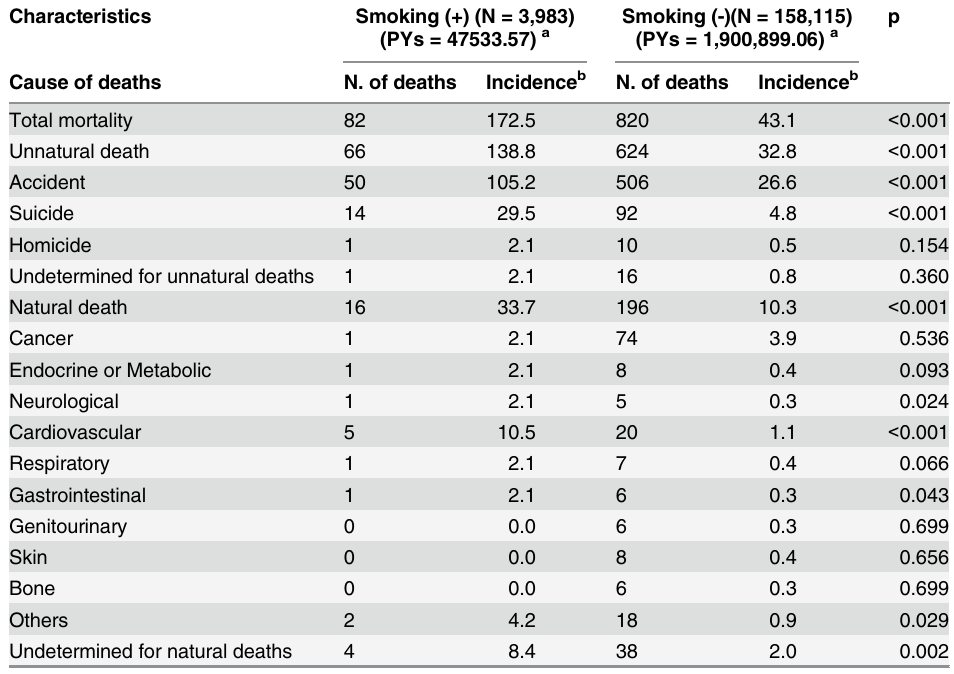
Table 2. Cause-specific mortality by smoking status (N = 162,098).